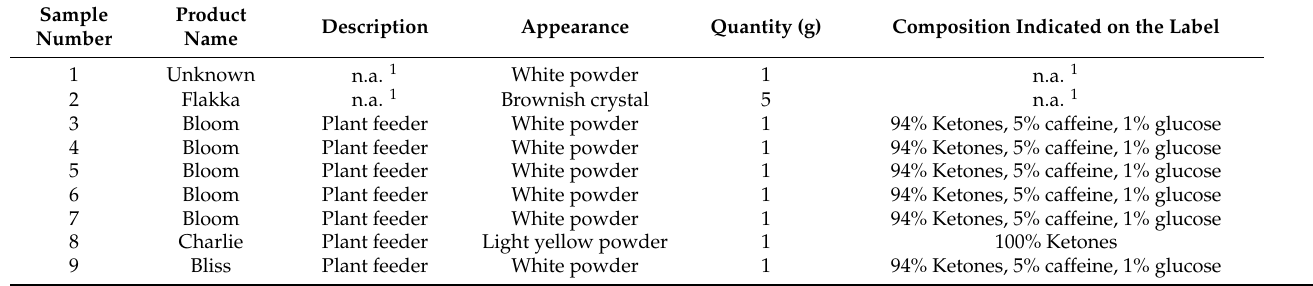
Table 1. List of provided samples with the information about their chemical composition indicated on the product